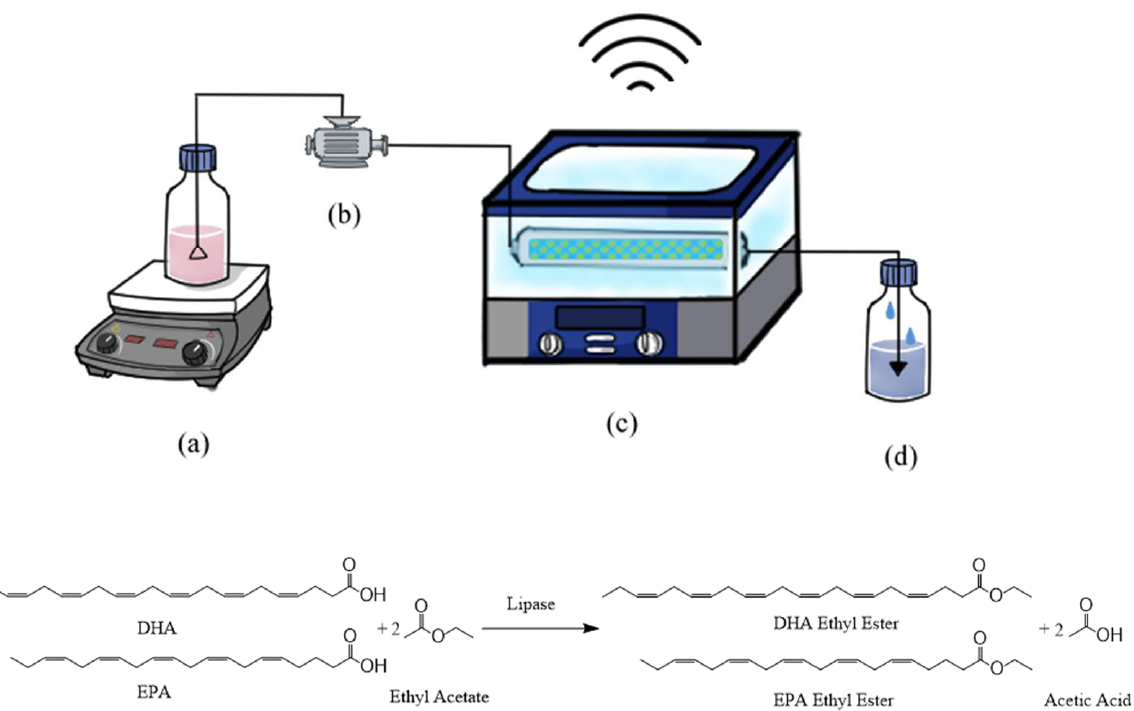
Figure 1. Diagram of the ultrasonic packed-bed bioreactor: ( a ) DHA + EPA concentrate in the EA; ( b ) pump; ( c ) temperature-controlled ultrasonic bath; ( d ) product.